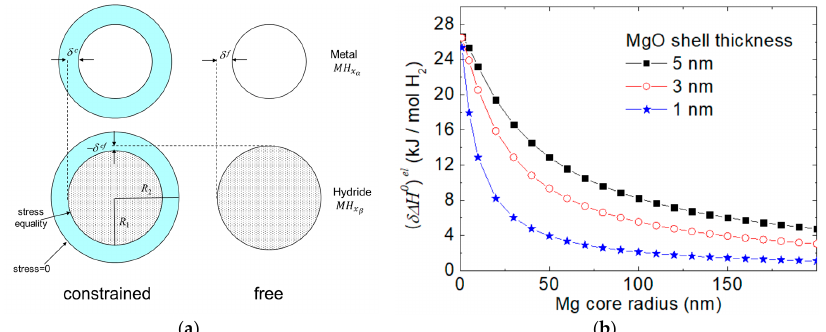
Figure 3. ( a ) Schematic representation of the elastic constraint mechanism in a hydride-forming NP embedded in a spherical shell; ( b ) hydride destabilization calculated for a Mg-MgO core-shell NP as a function of the radius, for three different thickness of the MgO shell [33].